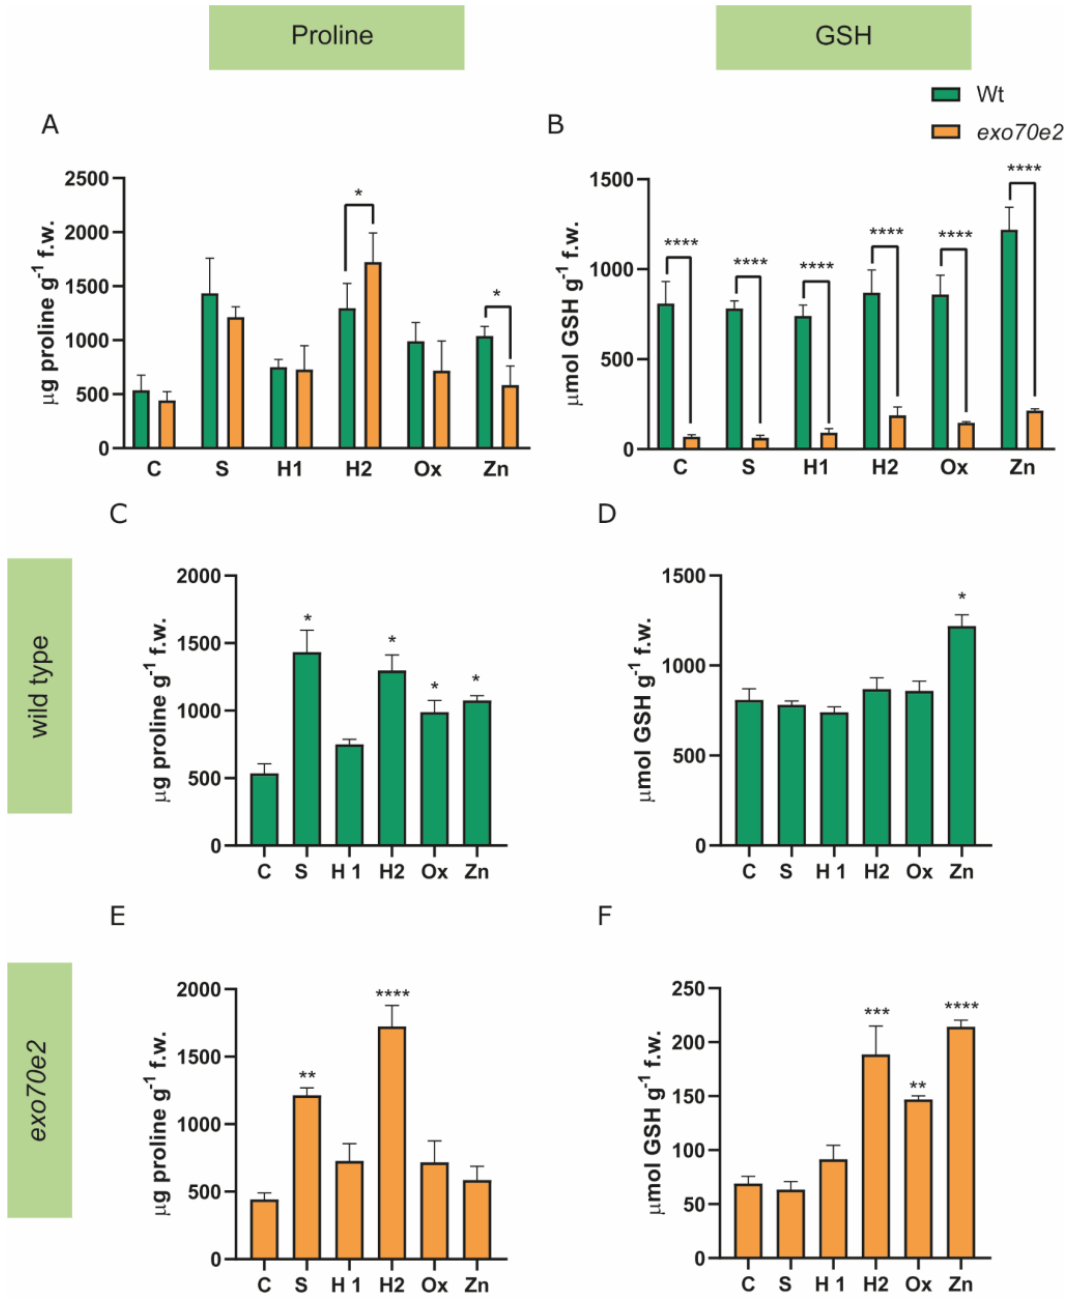
Figure 5. Proline (Pro) and GSH in exo70e2 plants in control and under stress. ( A , B ) Comparisons of Pro and GSH values between wt and exo70e2 plants. ( C , E ) Quantification of Pro accumulation in wt and exo70e2 plants, respectively, grown under stress. ( D , F ) GSH quantification in wt and exo70e2 plants, respectively, under stress. Results are presented as mean ± standard deviation (SD) of at least three experimental replicates (n ≥ 3). A significant decrease in GSH levels can be observed in exo70e2 plants in control conditions when compared to wt levels. An increase in GSH levels in H2, Ox, and Zn was also clear, along with an increase in Pro accumulation in S and H2 conditions. * ( p value ≤ 0.05); ** ( p value ≤ 0.01); *** ( p value ≤ 0.001); **** ( p value < 0.0001), according to the one-way ANOVA statistical tests. C—control; S—salt stress (50 mM NaCl); H1—drought stress (50 mM mannitol); H2—drought stress (10 mM mannitol); Ox—Oxidative stress (0.5 mM hydrogen peroxide); Zn—metal poisoning stress (150 µ M zinc